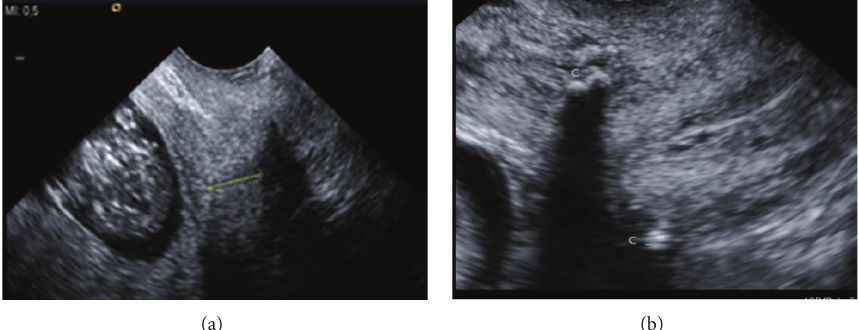
Figure 1: Inner cervical length of 11.4mm at 12+ 4/7 gestational weeks before abdominal cerclage (a) and at 20 weeks after the transabdominal cervicoisthmic cerclage. The Mersilene band is shown as an echogenic structure at the cervicoisthmic junction (C) and seemed to have increased the cervical length to 25 mm (not